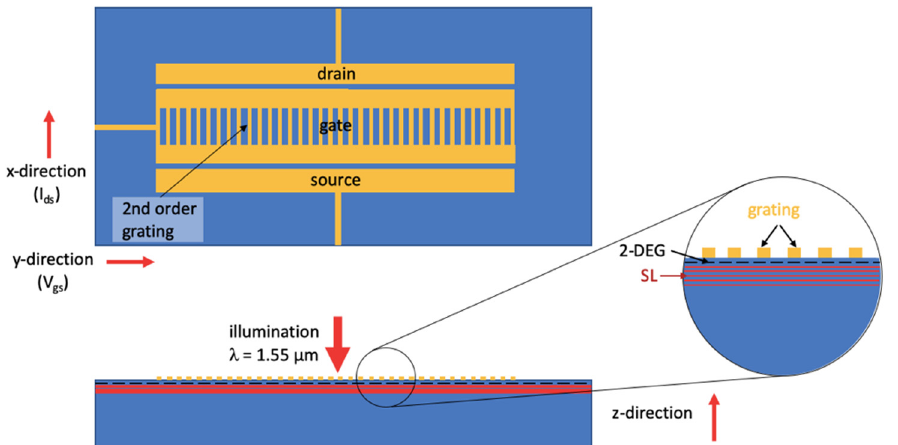
Figure 1. Top and side views as well as detail of the active region of a 1.55 µm optically activated HFET being illuminated via a second-order grating running along the y-direction. The metal grating has a period of 0.625 µm; and a thickness of 0.21 µm is used. For a better understanding, the InP grating cover is not shown. Geometrical directions are indicated by the red arrows.